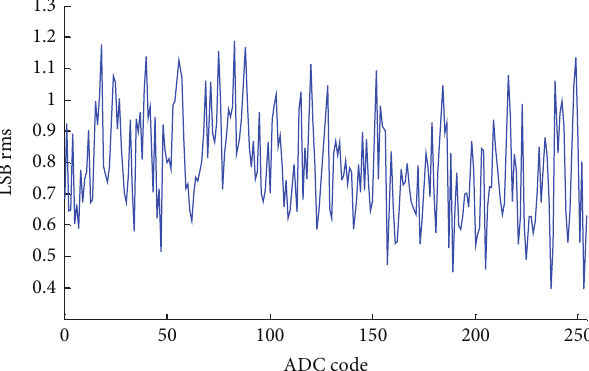
Figure 10: The measured DNL of the SAR ADC.